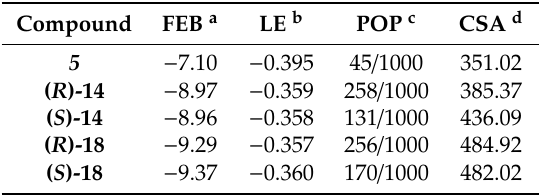
Figure 4. Docking poses of ( R ), ( A ), and ( S ), ( B ) enantiomer of compound 14 into the FAAH binding site. Table 5. (a) Free energy of binding (kcal/mol) as estimated by the AutoDock scoring function. (b) Ligand efficacy measured as the absolute FEB value divided by the number of heavy atoms. (c) Frequency of the selected cluster. (d) Contact surface area in Å 2 .